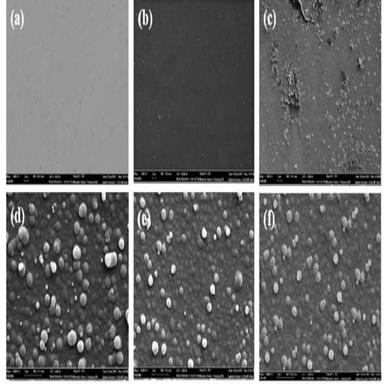
SEM images of a) bare ITO, b) CH, c) CH/rGO, d) p(BT) e) CH/p(BT) and f) CH/ rGO/p(BT) on ITO electrode surface.